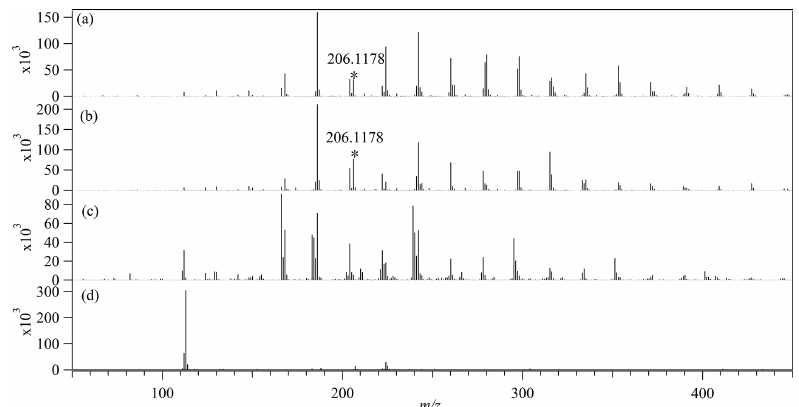
Figure 3. The direct-infusion ESI high-resolution mass spectra for the bag-wall residue samples in (a) the acrolein-ammonium NH 4 Cl bag, (b) the acrolein-ammonium (NH 4 ) 2 SO 4 bag and (c) the acrolein-ammonia bag. (d) The mass spectrum for the acrolein standard. The peaks at m/z 206.1178 assigned to the pyridinium compounds (C 3 H 4 O) 2 C 6 H 8 N + are labeled with